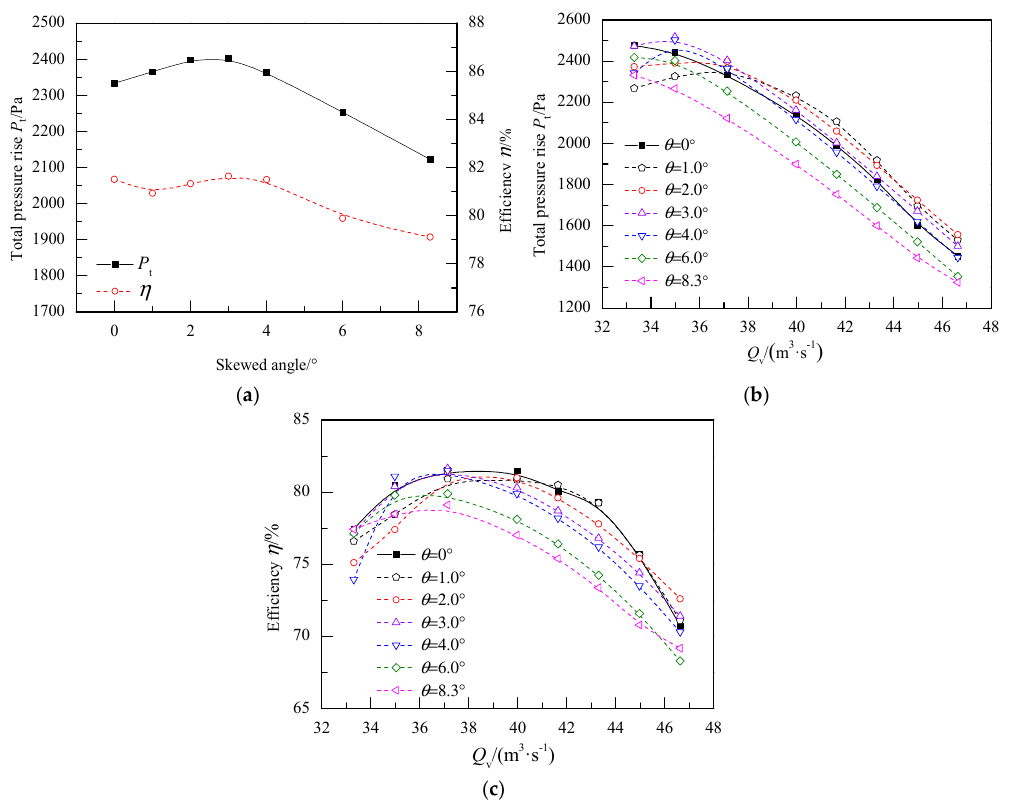
Figure 5. Effect of circumferentially forward-skewed blades on fan performance. ( a ) design condition; ( b ) variation in total pressure rise; ( c ) variation in efficiency.